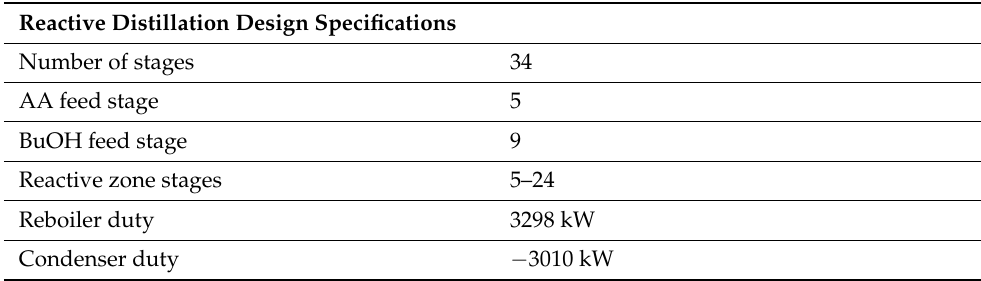
Table 8. Reactor design specifications for the RD